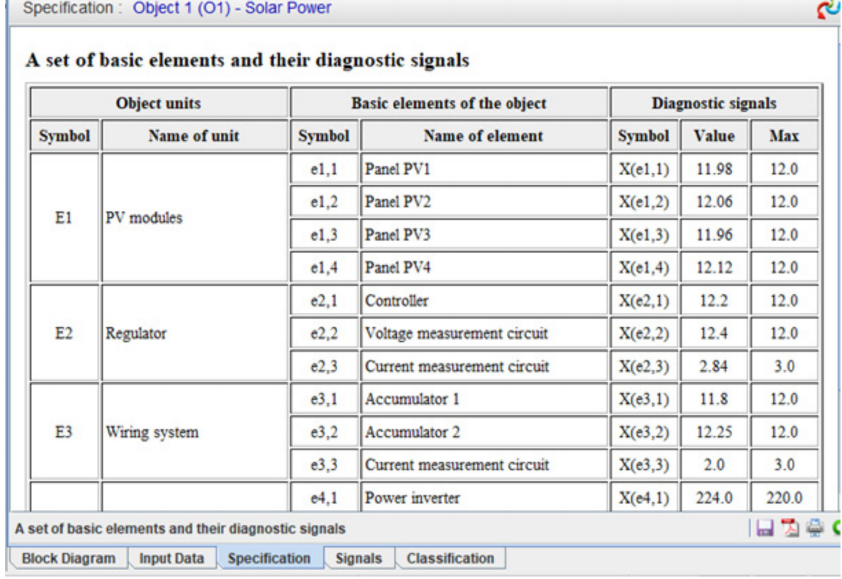
Figure 8. Technical object classification panel for “Signal values”